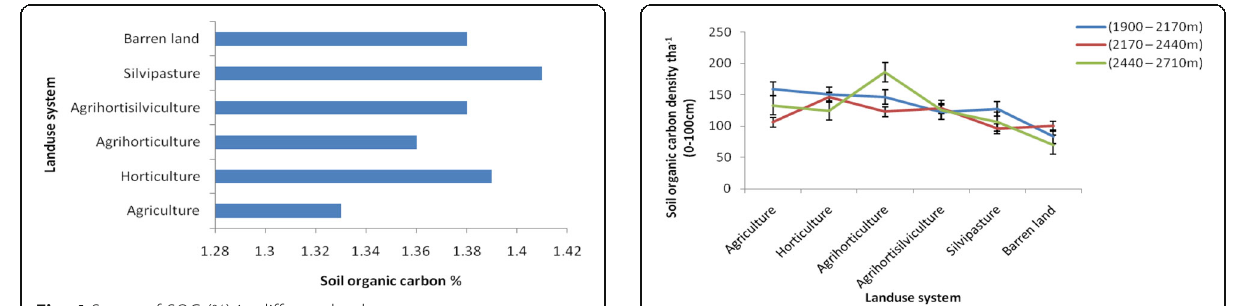
Fig. 6 Variation of SCD t ha − 1 in different land use systems along altitudinal gradient